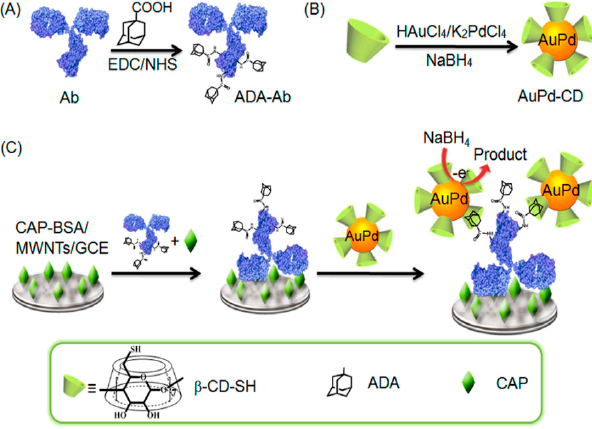
Figure 6. Preparation of ( A ) ADA − Ab conjugate and ( B ) β -CD-functionalized AuPd bimetallic nanoparticles, and ( C ) electrochemical immunoassay procedure for the detection of a small molecule. Reproduced with permission from [66].